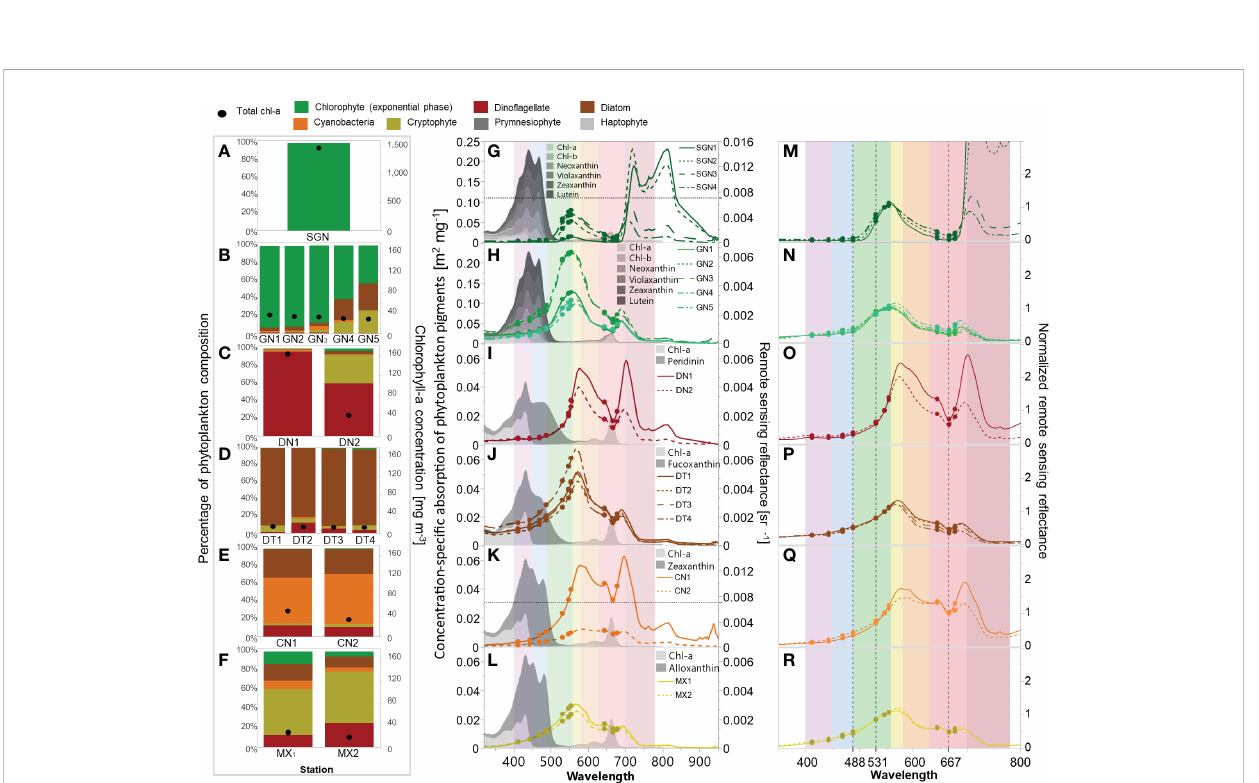
FIGURE 3 In situ chl-a and CHEMTAX-derived phytoplankton group composition (left), R rs spectra and concentration-speci fi c absorption of pigment markers of the dominant phytoplankton groups retrieved from Clementson and Wojtasiewicz (2019) employed in the CHEMTAX analysis (middle), and R rs spectra normalized to R rs 547 (right) of super green Noctiluca (A, G, M) , strong-to-weak green Noctiluca (B, H, N) , dino fl agellate (C, I, O) , diatom (D,